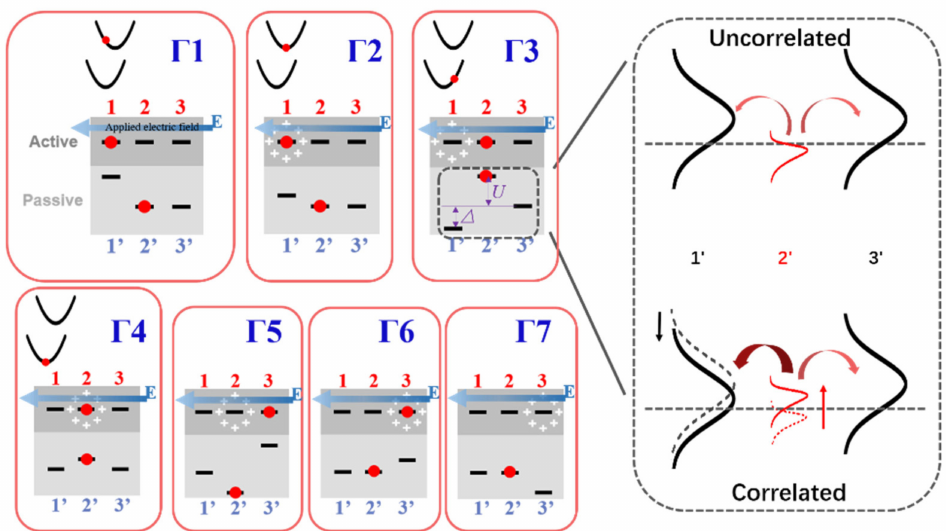
Figure 2. The electron and quasi-particle transfer process in the active line and the energy fluctuation in the passive line. The insert figure shows the site energy in the passive line described by a Gaussian distribution. “Uncorrelated” and “Correlated” respectively indicate the states before and after being affected by the deformed lattices and the electrons in the active